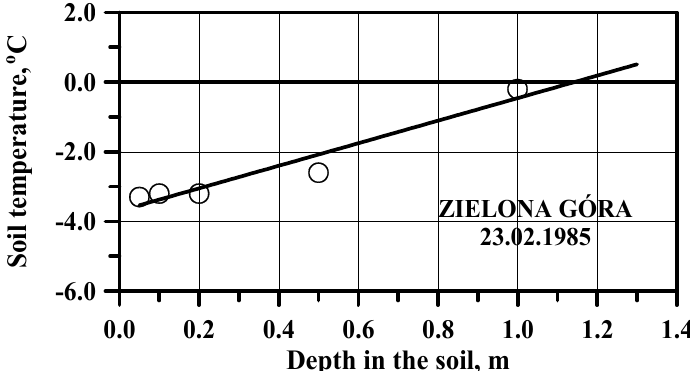
Figure 2. Example of extrapolation of the data on the soil temperature made in order to define maximal winter value adapted from [19].